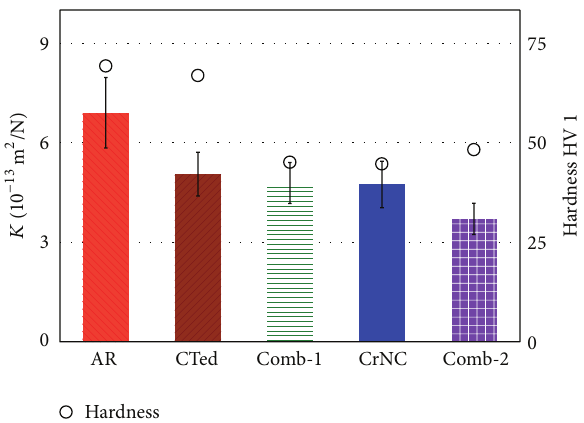
Figure 7: Wear rate and substrate hardness of all specimens types.